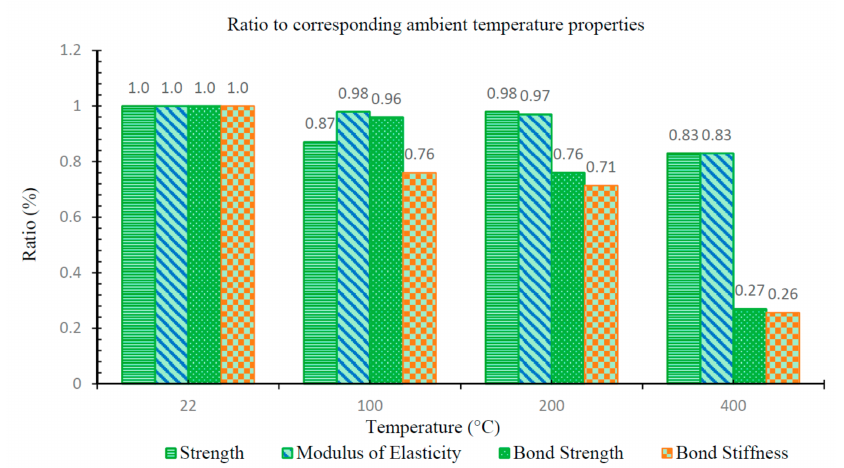
Figure 8. Ratios of residual parameters of pre-heated specimens with respect to their corresponding unheated test